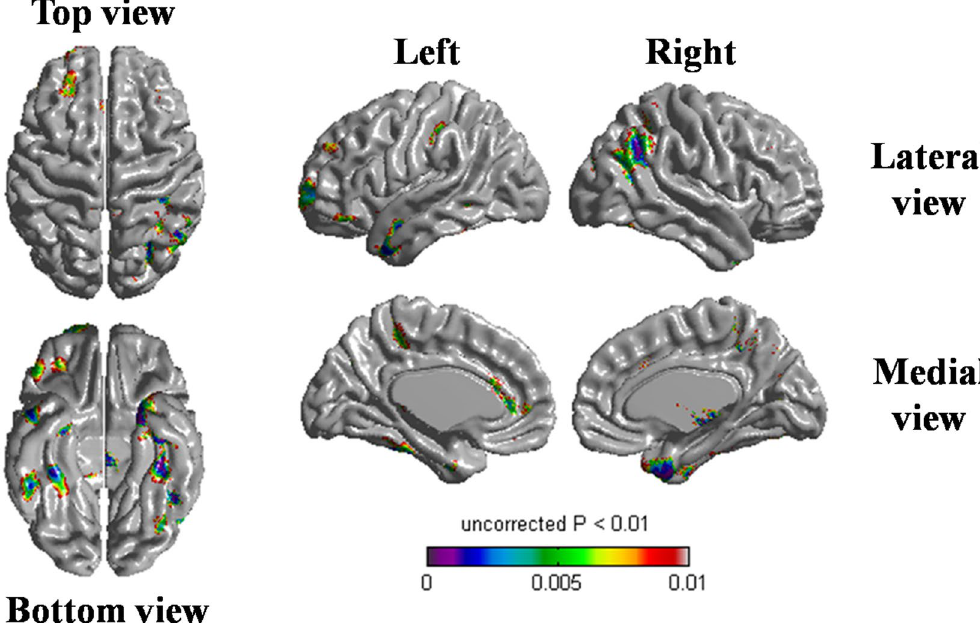
Figure 1. Statistical map shows regions where APOE2 carriers had slower rate of cortical thinning compared to APOE3 homozygotes. Compared to the APOE3 homozygotes, APOE2 carriers showed slower cortical thinning in the left dorsolateral frontal, lateral temporal, medial frontal; right lateral parietal, medial temporal; and bilateral inferior temporal areas. Linear mixed effects model was performed using group (APOE genotype), time, age, gender, intracranial volume, and the interaction term between group and time (group-by-time) as fixed effects; and patient as a random effect (uncorrected p < 0.01). Abbreviation: APOE, apolipoprotein